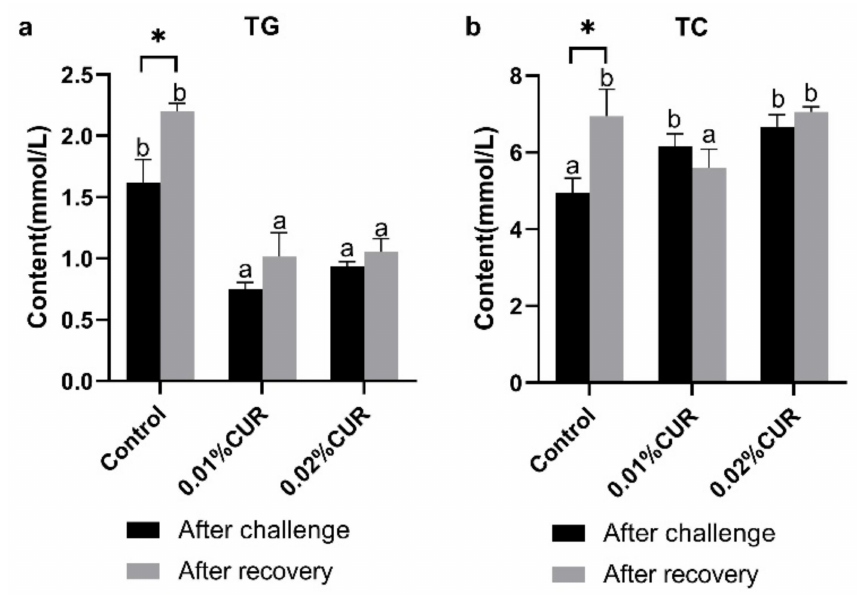
Figure 5. ( a ) Triglyceride (TG) and ( b ) total cholesterol (TC) content of greater amberjack fed with dietary curcumin supplementation after ammonia nitrogen challenge assay. (Different letters above bars and asterisk sign (*) indicate significant differences at the 0.05